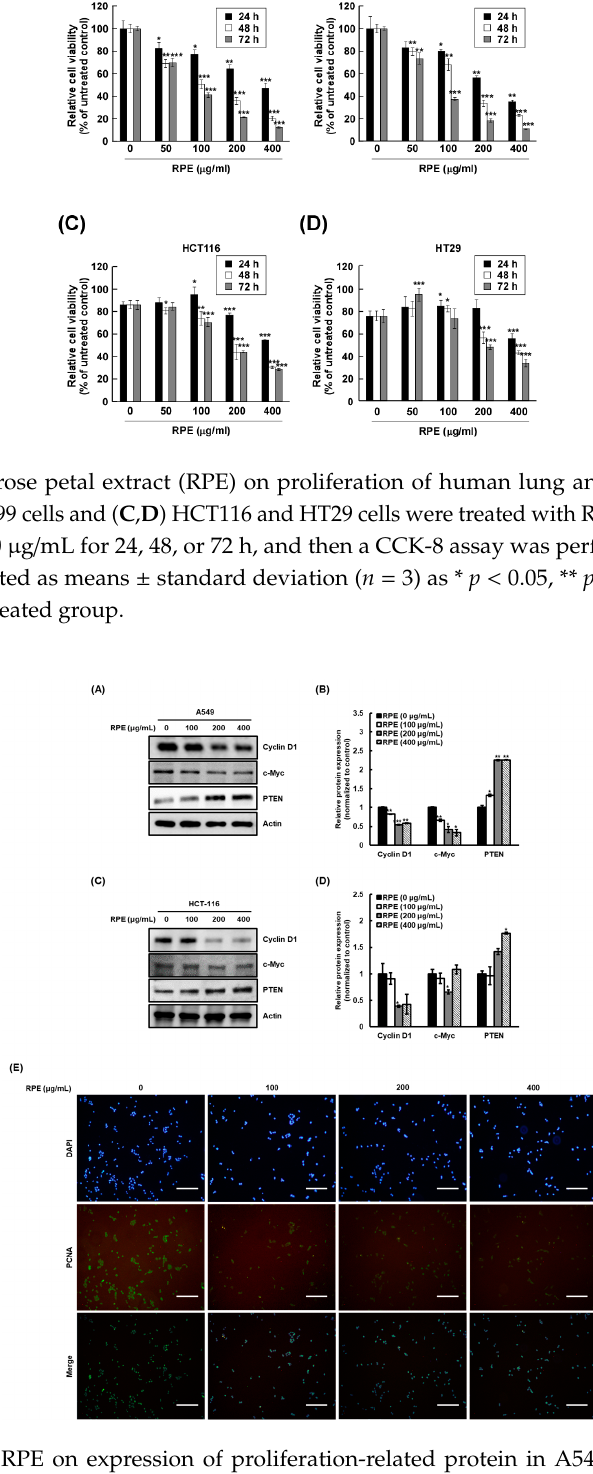
Figure 1. Effect of rose petal extract (RPE) on proliferation of human lung and colon cancer cells. ( A , B ) A549 and H1299 cells and ( C , D ) HCT116 and HT29 cells were treated with RPE at a concentration of